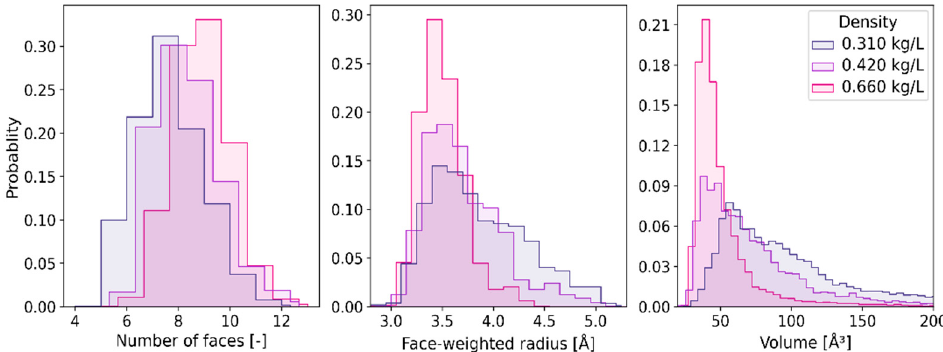
Figure 5. Histograms representing the effect of density on the statistical distribution of the number of faces (left), face-weighted radius (central), and VP-volume (right) at the supercritical temperature 673 K.